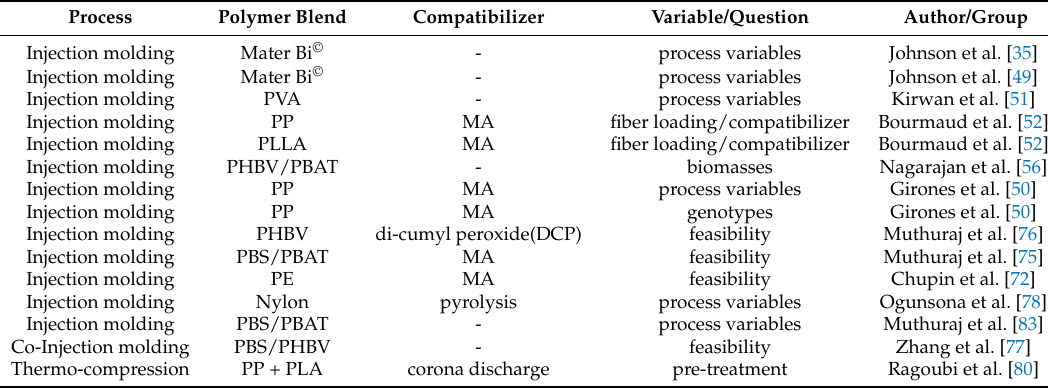
Table 1. The different biocomposites produced based on Miscanthus fibers and